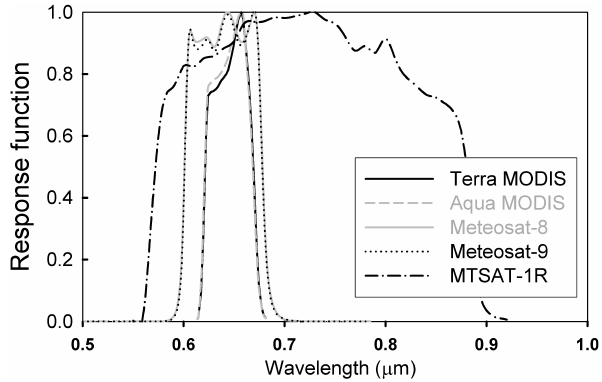
Fig. 1. SRFs of MODIS 0.646-µm channels aboard Terra and Aqua, SEVIRI 0.640-µm channels aboard Meteosat-8 and Meteosat-9, and MTSAT-1R 0.724-µm